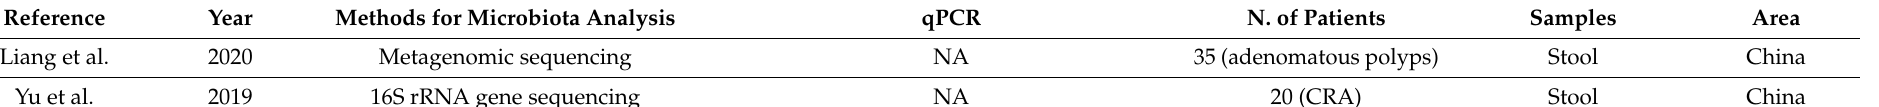
Table 1. Details of studies ( n = 19) included in the review. CRA: colorectal adenoma; CRC: colorectal